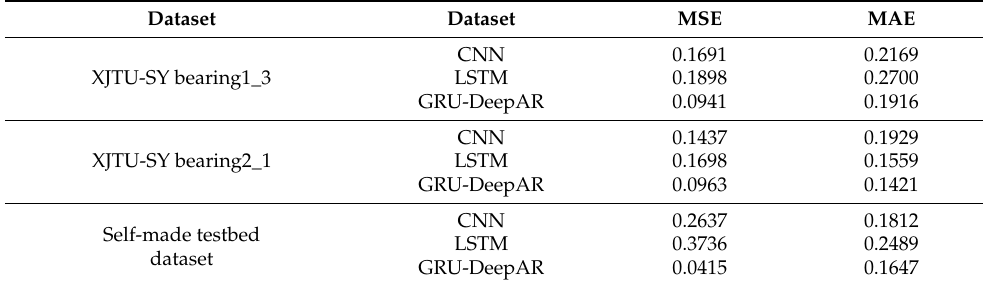
Table 4. Comparison of prediction accuracy of different